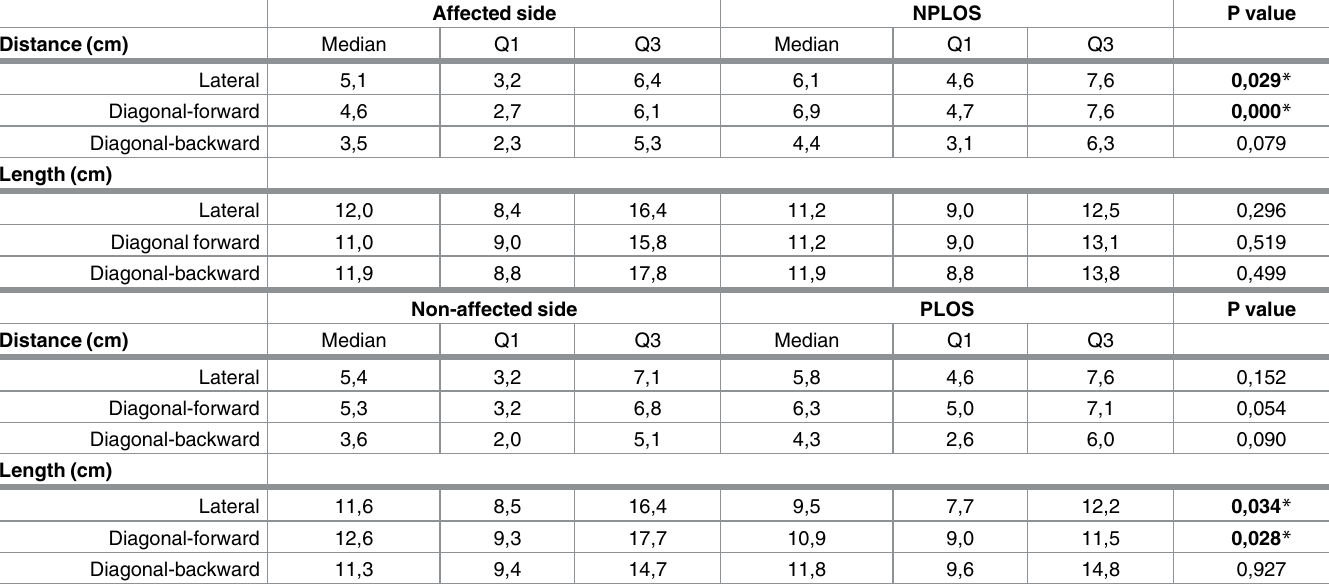
Table 2. Comparison between patients with stroke (n = 36) and healthy controls (n = 32) for force platform parameters.